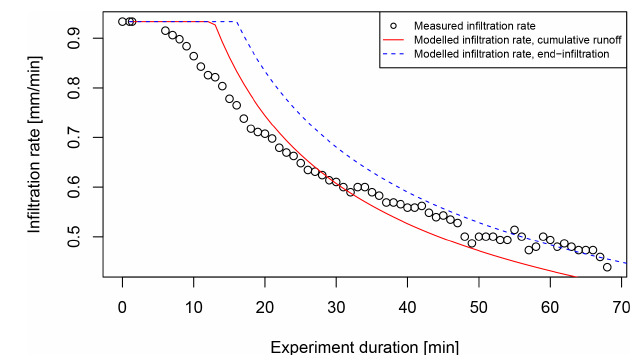
Figure 1. Modelled infiltration rates resulting from different meth- ods of skinfactor determination. Calculated infiltration rate is lim- ited by rainfall intensity (0.933mmmin − 1